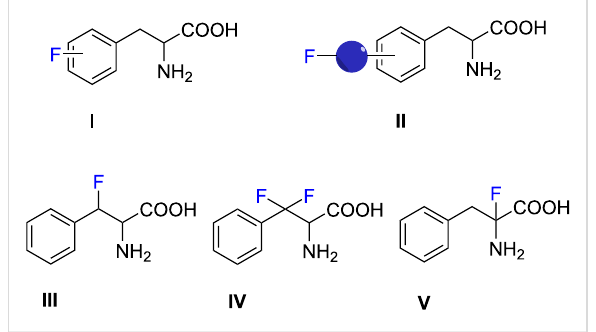
Figure 1: Categories I – V of fluorinated